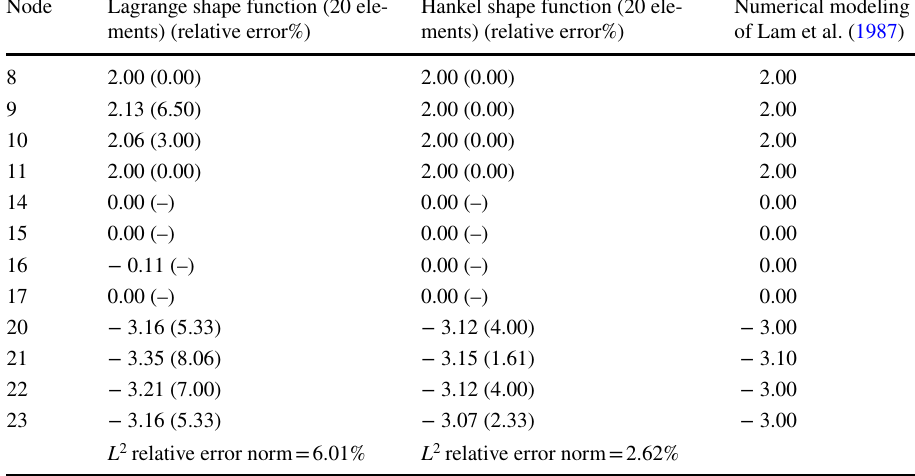
Hankel shape function (20 ele- ments) (relative error%)